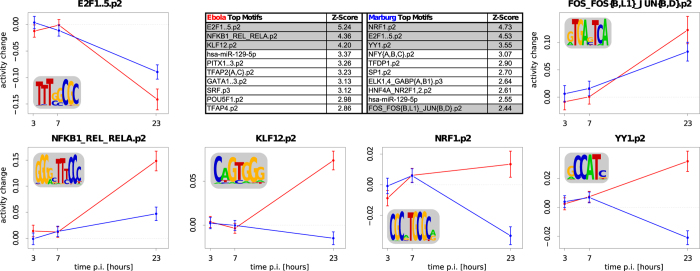
Motif activity response analysis.The table shows the top significant motifs after the infection of HuH7 cells with EBOV (red) or MARV (blue) compared with the response in Mock controls. Regulated motifs are predicted to target (1) the cell cycle (E2F1..5.p2) by down-regulating CDC6, PCNA and MCM6; (2) NFκB -signaling (NFKB1_REL_RELA.p2) by targeting CXCL isoforms, ELF3, NFκB isoforms, FOSL2 and JUN; (3) EGR1 expression in EBOV-infected cells (KLF12.p2, YY1.p2 and others); or (4) chromatin organization in MARV-infected cells (NRF1.p2, YY1.p2 and others). For selected motifs, the inferred activity changes (points +/−1 SD) after EBOV or MARV infection relative to the corresponding Mock controls are shown for the different time points (3, 7 or 23 h p.i.) adjacent to and below the table. Selected regulatory motifs, the associated genes and their important targets (including their fold change between two time points) can be viewed in Section ES5 and are summarized in File ES5D.